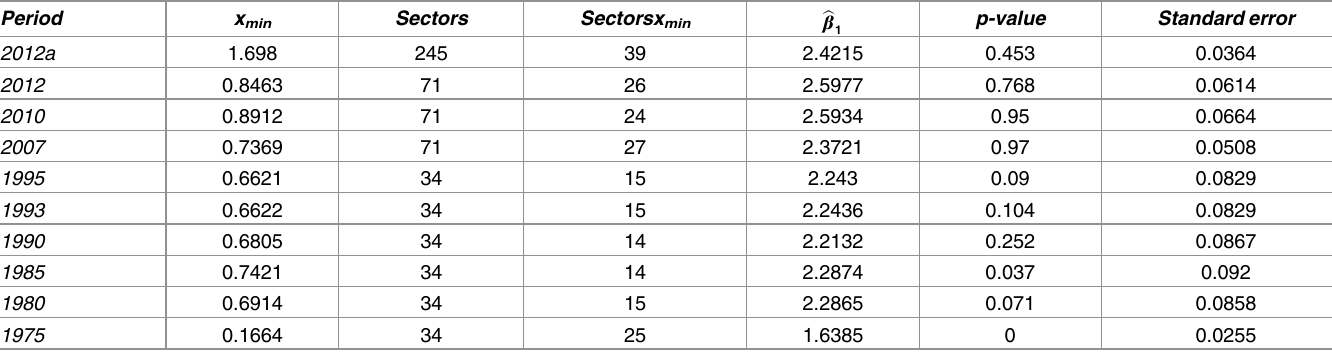
Table 2. Power-law test for first-order degrees of